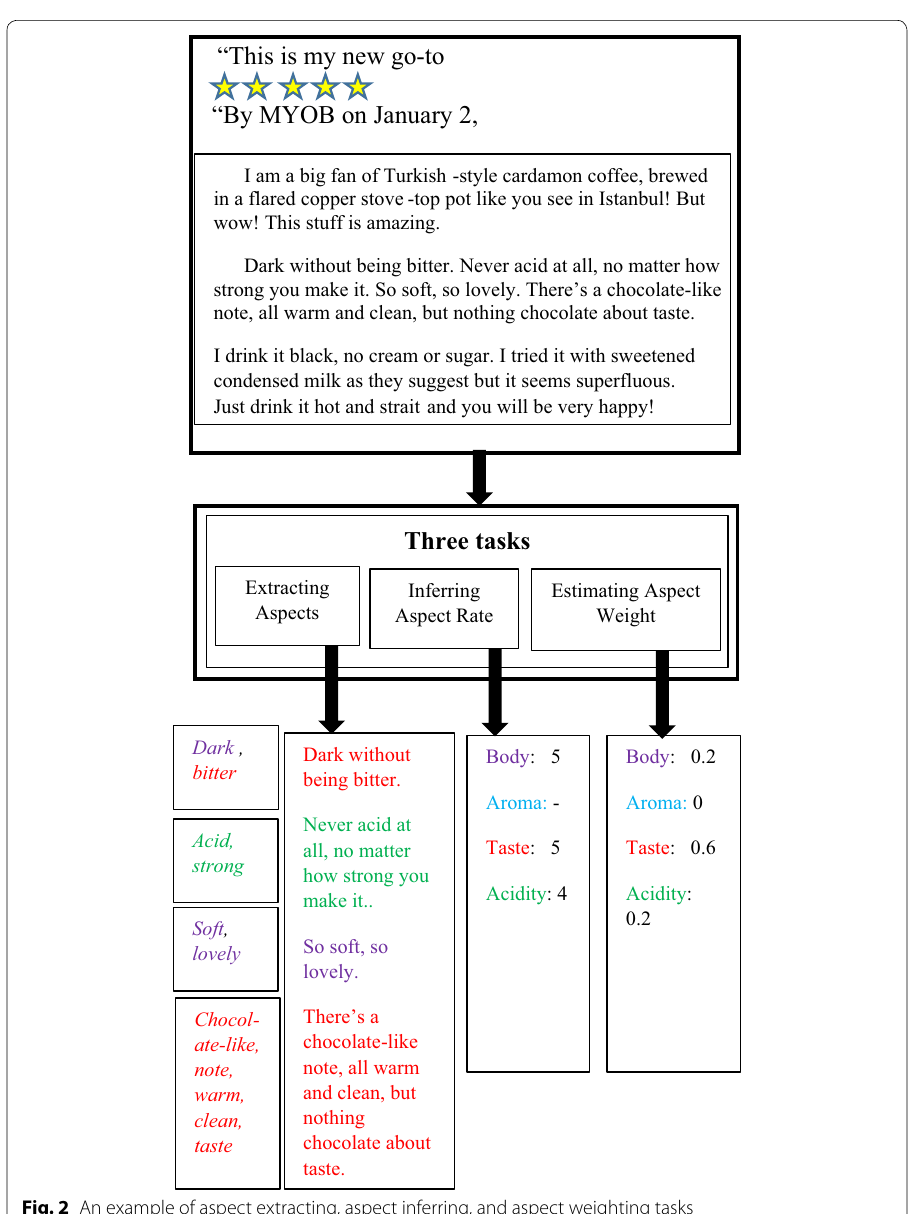
Fig. 2 An example of aspect extracting, aspect inferring, and aspect weighting